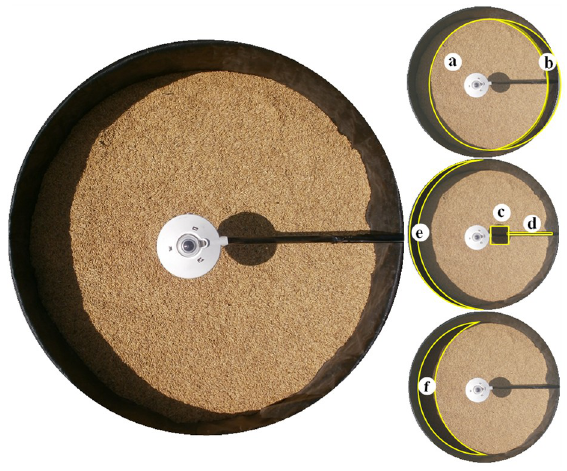
Figure 4. Top view of shadows created by the circular shield, the pyranometers and the support rod with ( a ) unshaded paddy rice, ( b ) unshaded circular shield, ( c ) pyranometer shadow, ( d ) support rod shadow, ( e ) crescent shade of the circular shield, and ( f ) shaded part of the circular shield.